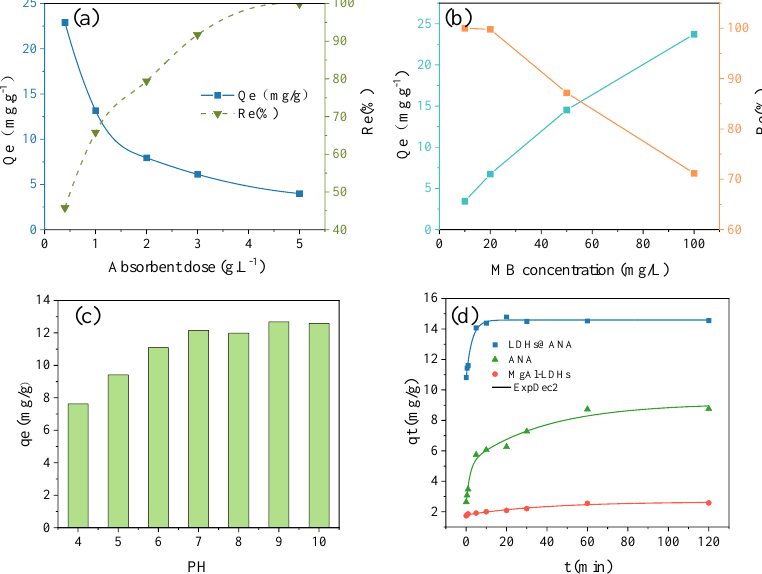
Figure 8. ( a ) Effects of absorbent dose amount of LDHs@ANA composite on MB adsorption (c(MB) = 20 mg/L, T = 293 K, Ph = 7.0, t = 1 h); ( b ) effects of initial MB concentration on the adsorption of MB by LDHs@ANA (m/V = 3 g.L − 1 , T = 293 K, Ph = 7.0, t = 1 h); ( c ) effects of initial pH on MB adsorption by LDHs@ANA (m/V = 3 g.L − 1 , c(MB) = 50 mg/L, T = 293 K, t = 1 h); ( d ) Comparison of MB adsorption capacity by LDHs, ANA, and LDHs@ANA (T = 293K, m/V = 3g · L − 1 , pH = 7.0, c(MB) = 50mg · L − 1 , t = 1h, and the dashed lines were guided for the eye and represented an expo- nential behavior of